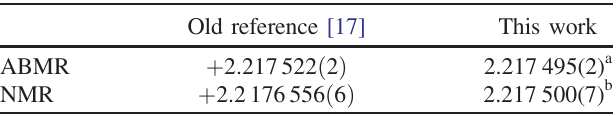
TABLE III. μ ð 23 Na Þ = μ reference nuclear magnetic dipole N moment from ABMR and NMR experiments.